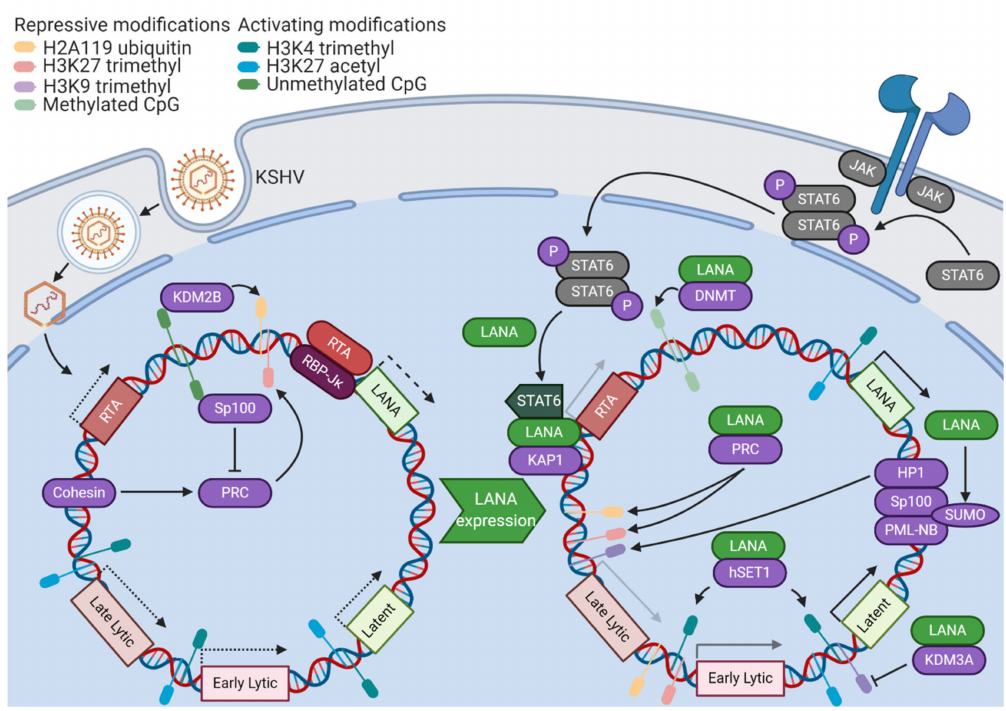
Figure 1. The Kaposi’s sarcoma-associated herpesvirus (KSHV) genome enters a latent state after de novo infection. In some cells, early expression of lytic genes such as replication and transcription activator (RTA) triggers expression of the master organizer of latency, latency-associated nuclear antigen (LANA). LANA recruits many components of the host epigenetic machinery to promote the formation of latent KSHV episomes. A pattern of transcriptionally-permissive histone modifications across the KSHV genome gives way to a generally-repressive chromatin state, sparing robust latent gene expression. Lytic gene expression becomes minimal but poised for upregulation upon